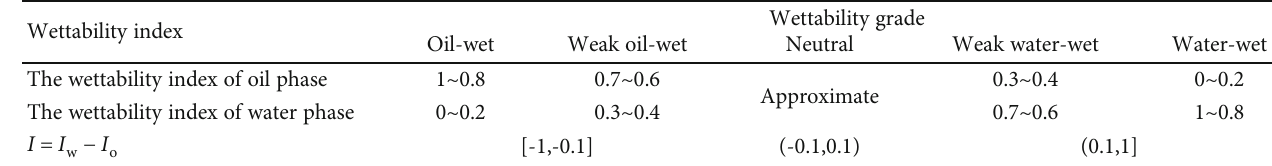
Table 1: The wettability grading standards.